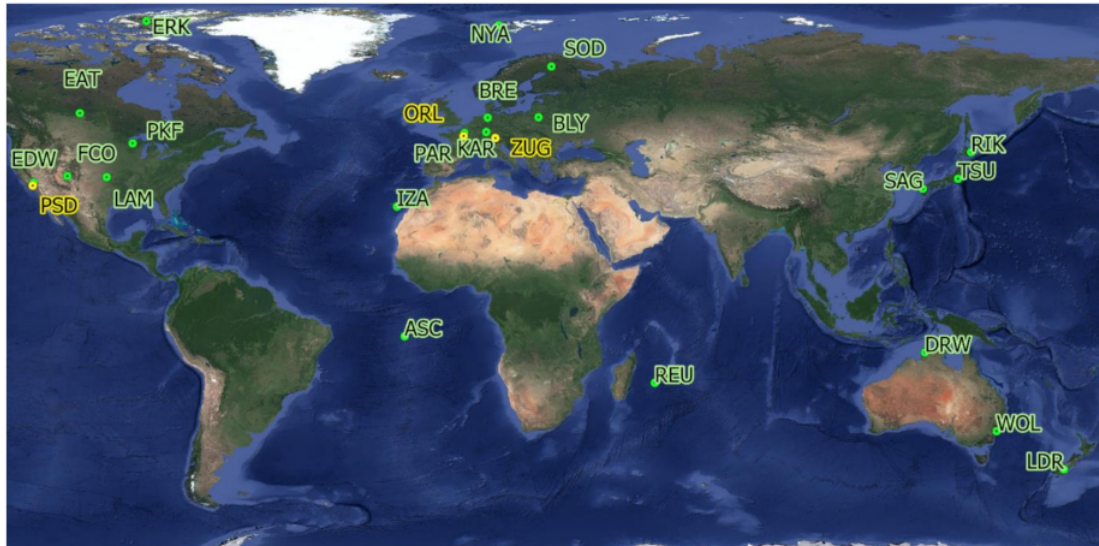
Figure 1. Geographical distribution of TCCON sites used in this study. Colors are shown for better distinguishing neighboring measurement sites. Description of acronyms, used for each measurement site and detailed maps of the regions congested with several TCCON stations, are provided in the Supplementary Materials. The satellite map provided by © Google maps is embedded using QuickMapServices plugin. The detailed map of Central Europe is shown in the Supplementary Materials (Figure